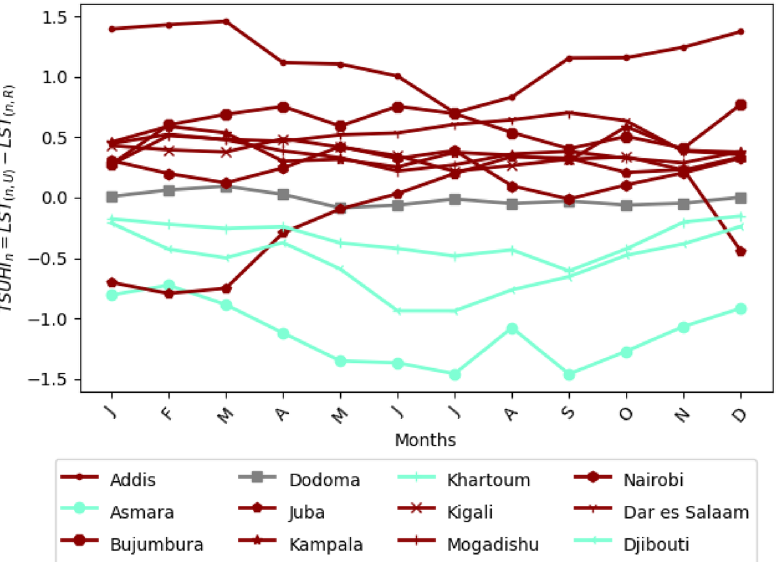
Figure 7. Seasonal cycle of tropical surface urban heat islands (TSUHIs) in the greater horn of Africa during the night. Cities with the night time heat islands are shown with red lines, with no observed night time heat islands are shown by the gray line, and with the night time cool islands are shown with the aquamarine